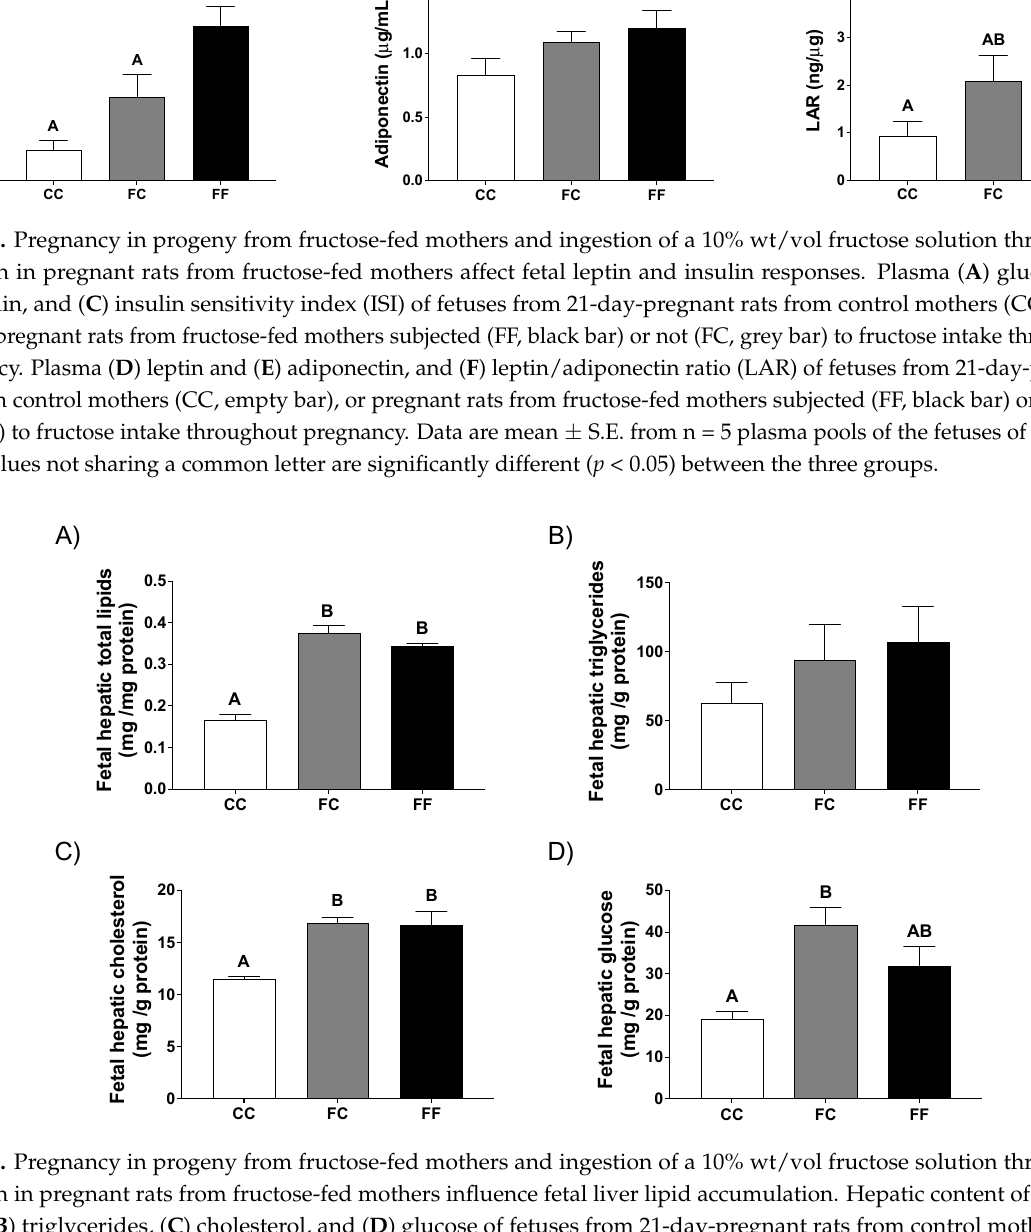
Table 3. Plasma analytes and liver gene expression in fetuses from pregnant rats from fructose-fed mothers subjected (FF) or not (FC) to fructose intake throughout pregnancy and fetuses from control mothers (CC).